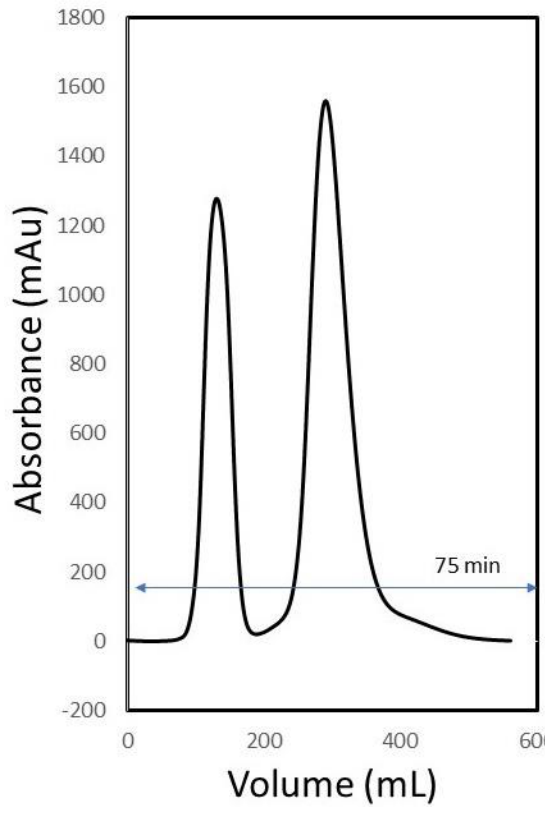
Figure 9. Chromatogram obtained during BSA (5 mg/mL) and lysozyme (2.5 mg/mL) separation using the 200 mL z 2 cuboid SEC device by loading 40 mL of feed sample at an 8 mL/min flow rate (medium: Sephacryl S-200 HR; mobile phase: phosphate-buffered saline (pH 7.4)).